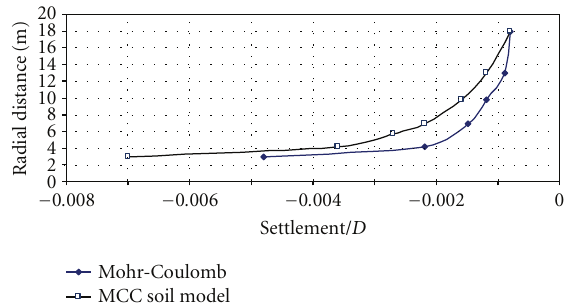
Figure 9: Variation of the vertical settlement along the radial distance along section D-D above the